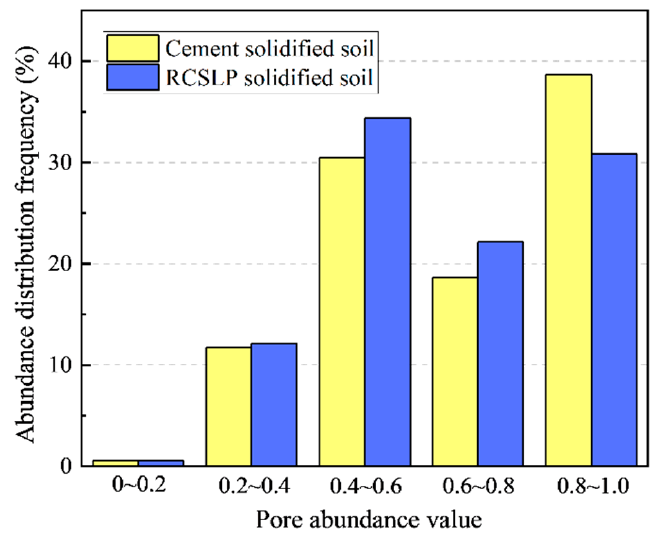
Figure 20. Pore abundance of the solidified soil.